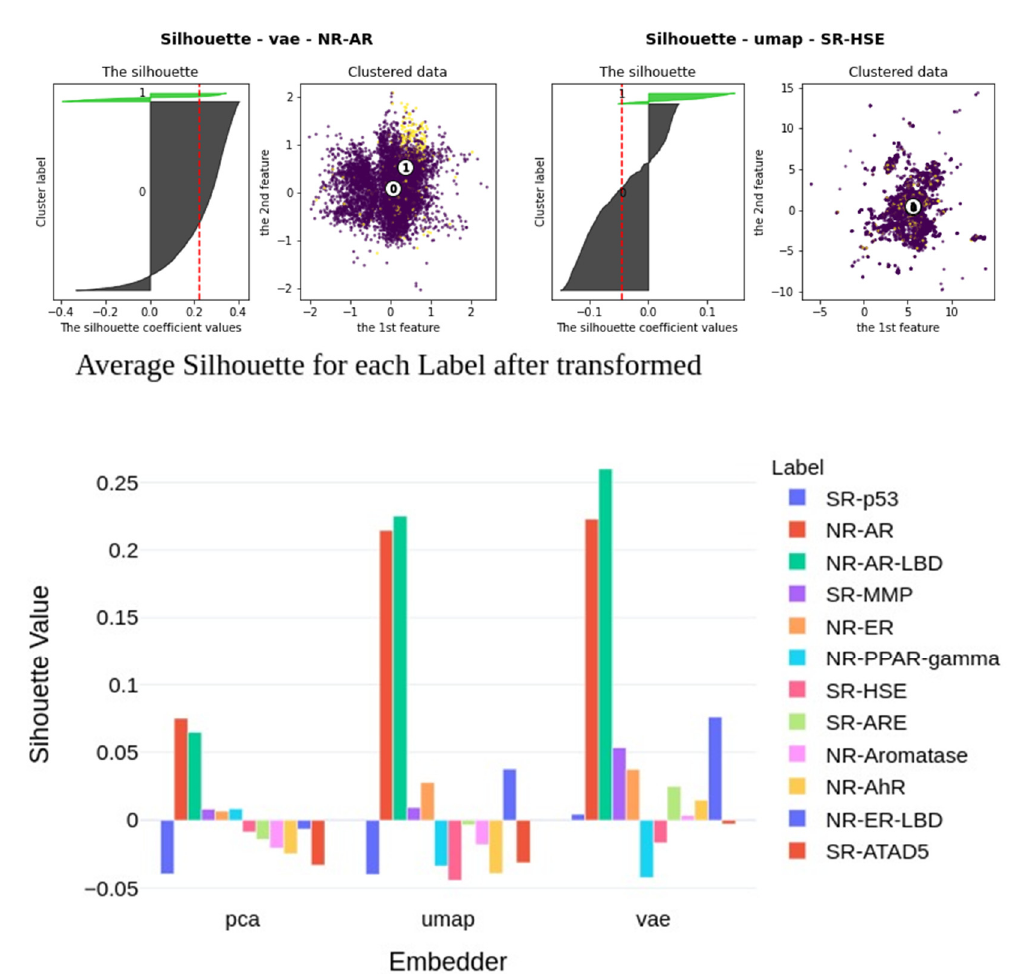
Figure 6. Top: Silhouette plots for best (top left) and worst (top right) performing clustering, which are VAE with NR-AR and UMAP with SR-HSE, respectively. The gray and green masses are points in two classes (0 and 1) with their silhouette coefficients, respectively. The dashed red line is the average value of both. The scatter plot visualizes their coordinates in the 2D embedded space. The number is their center points for each class (0 and 1). We notice that, for the best clustering, the silhouette coefficient tends to be higher, and points that belong to NR-AR label visually agglomerate together. Conversely, the silhouette coefficient seems to be negative for the worst clustering, and the points belonging to SR-HSE label are visually indistinguishable from other points. Silhouette coefficients for externally embedded CS2 data (bottom) by means of the three embedders (PCA, UMAP, VAE) calculated per label, which are presented by the color map. We see that VAE gains a higher silhouette coefficient on most tasks than UMAP or PCA, indicating a better